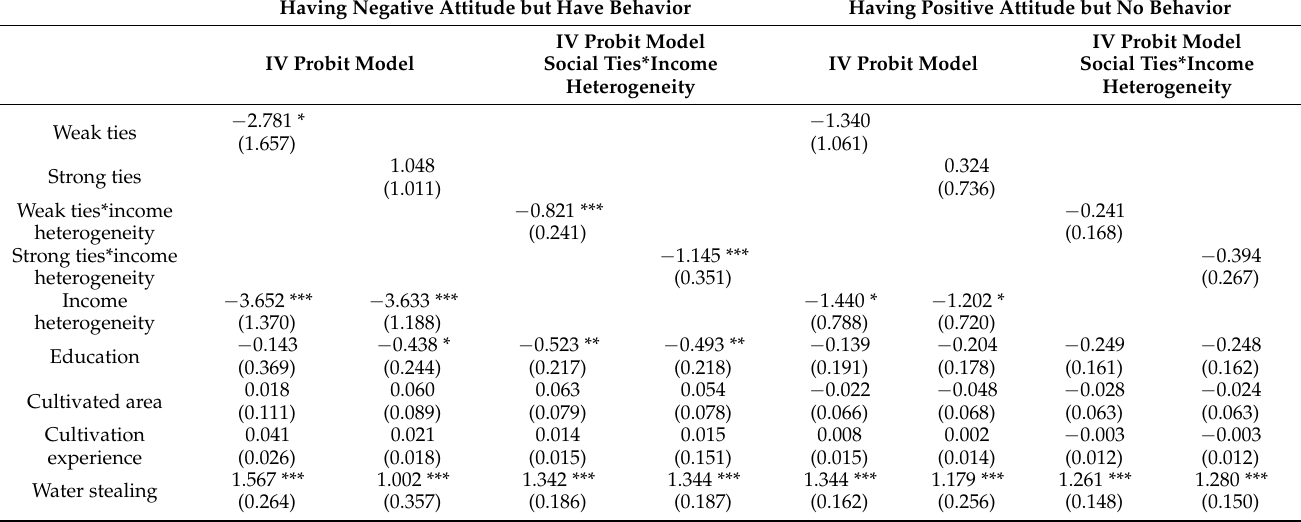
Table 3. Comparison between the two forms of attitude–behavior paradox: “having negative attitude but have behavior ” and “having positive attitude but no